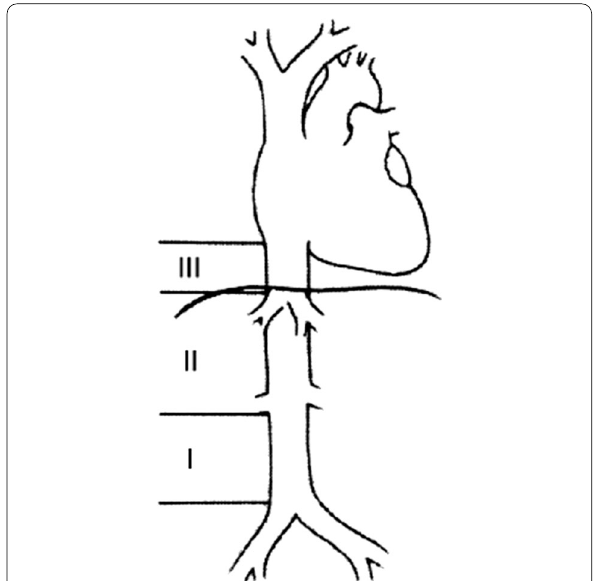
Fig. 4 A classification of LMS according to their location the different segments of the